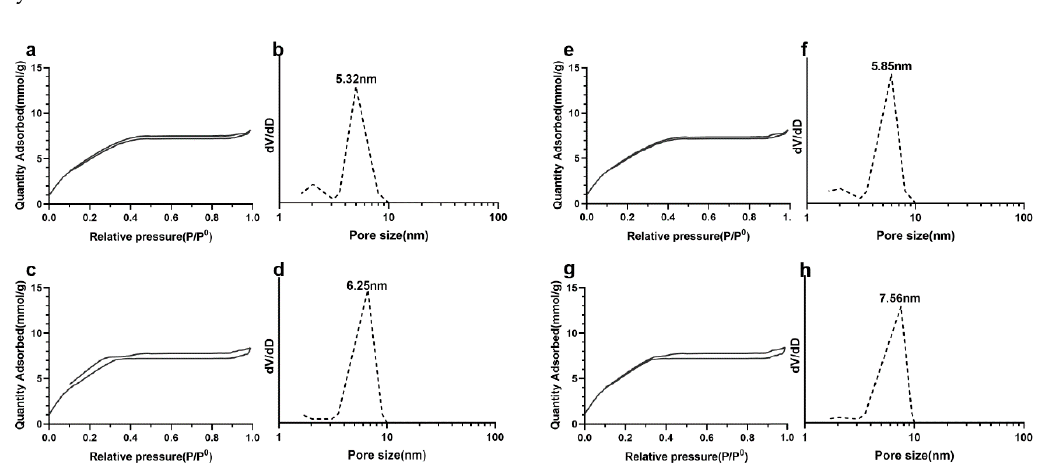
Figure 7. N 2 adsorption–desorption isotherm and pore size distribution of Ag@SiO 2 . ( a , b ) Ag@SiO 2